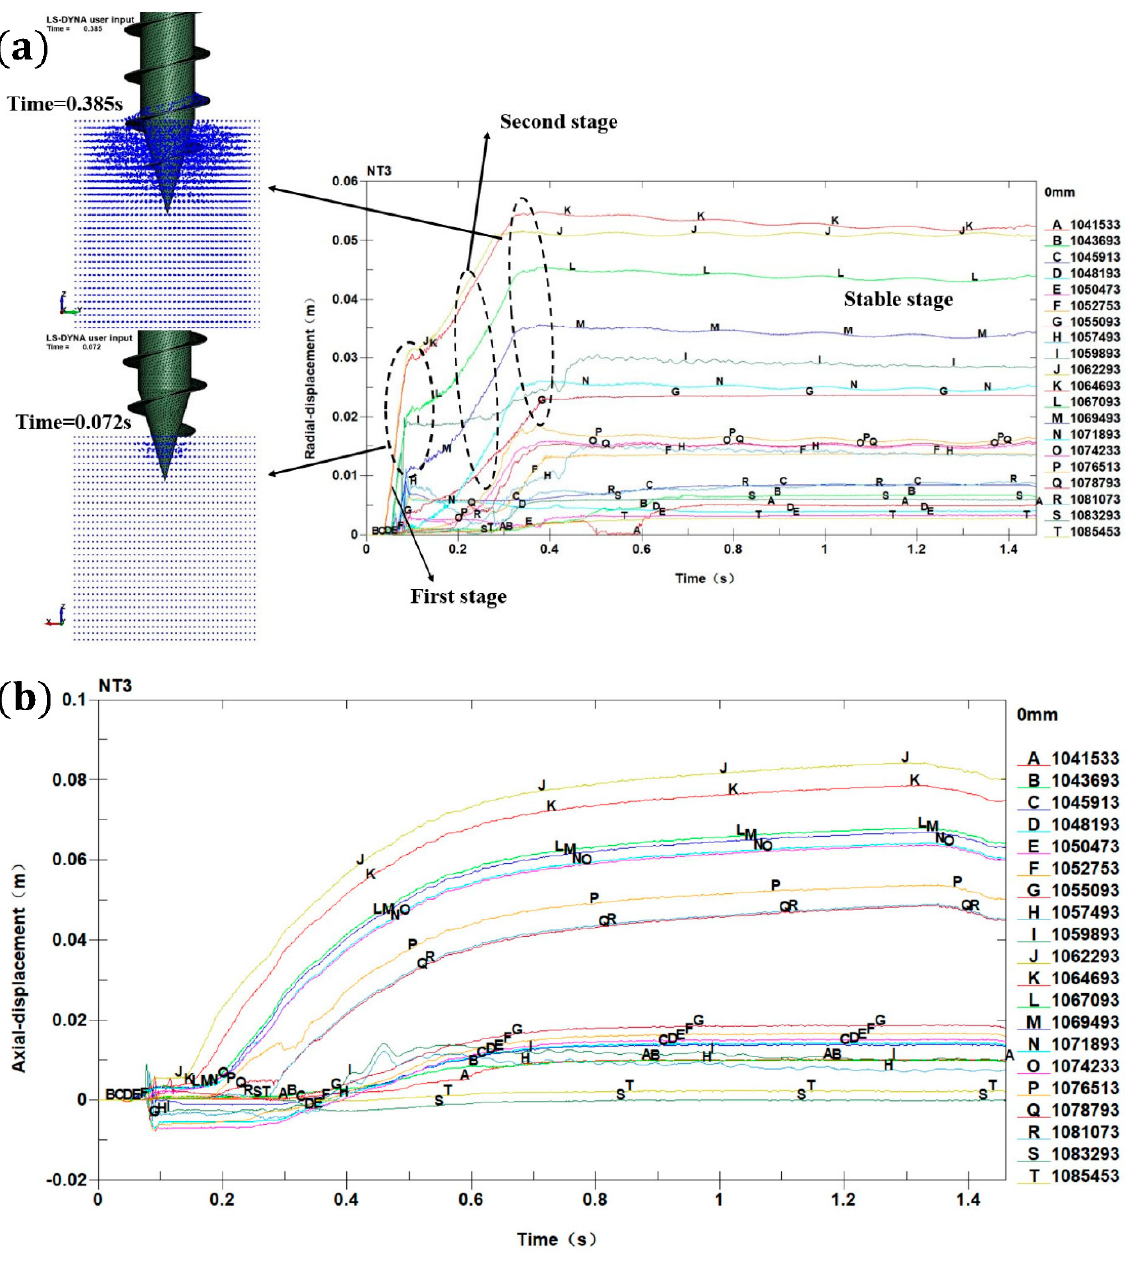
Figure 14. Displacement of the shallow soil particles in different directions:( a ) radial and ( b ) axial.